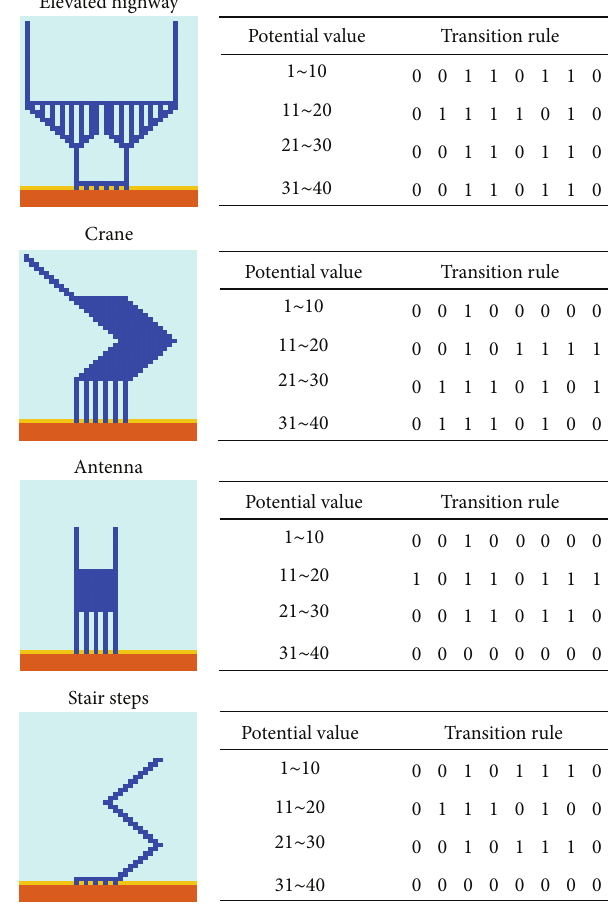
Figure 9: Results owing to various transition rules. It is thought that various structural shapes can be produced and they are applicable to marine